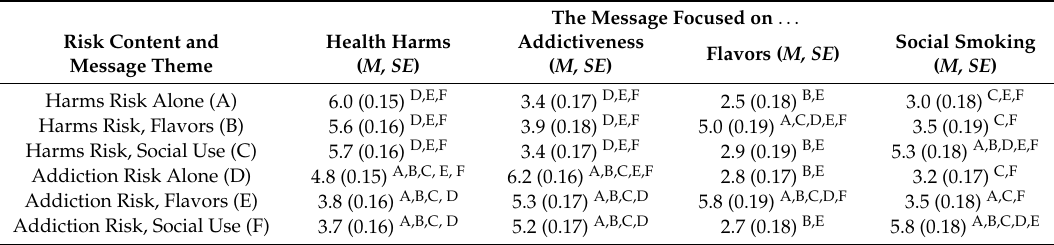
Table 2. Least squares mean di ff erences for manipulation check items.